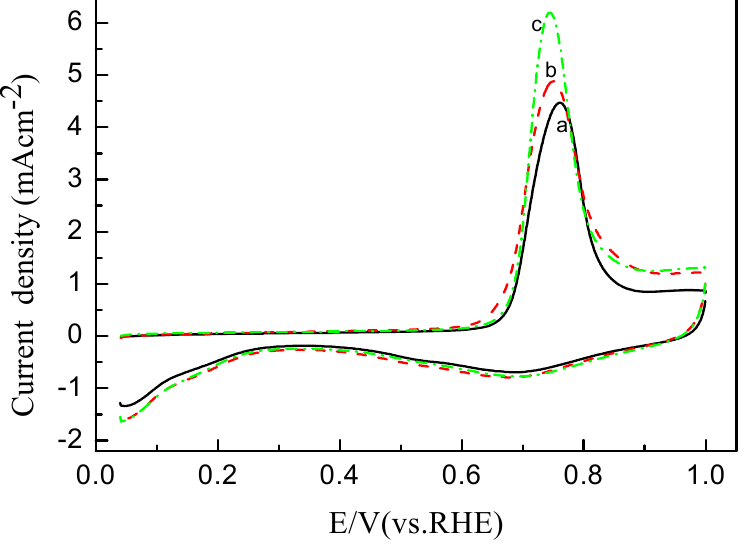
at a scan rate of 20 mV s − 1 4